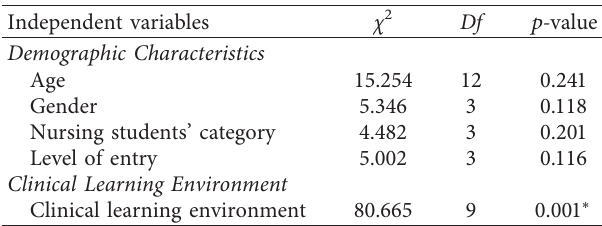
Table 3: Association between selected demographic characteristics, clinical learning environment, and respondents’ satisfaction with their clinical rotation experience.